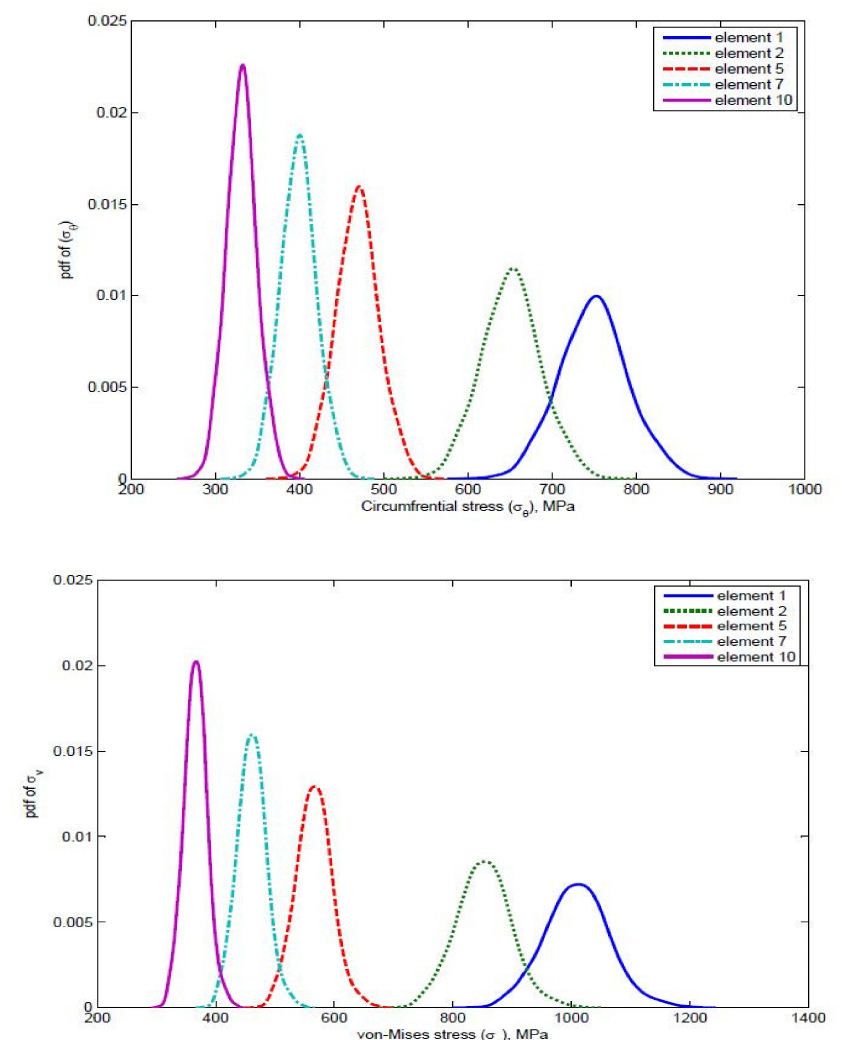
Figure 19. Comparison of circumferential stress and von Mises stress for different elements when E , P , and ∆ T are random